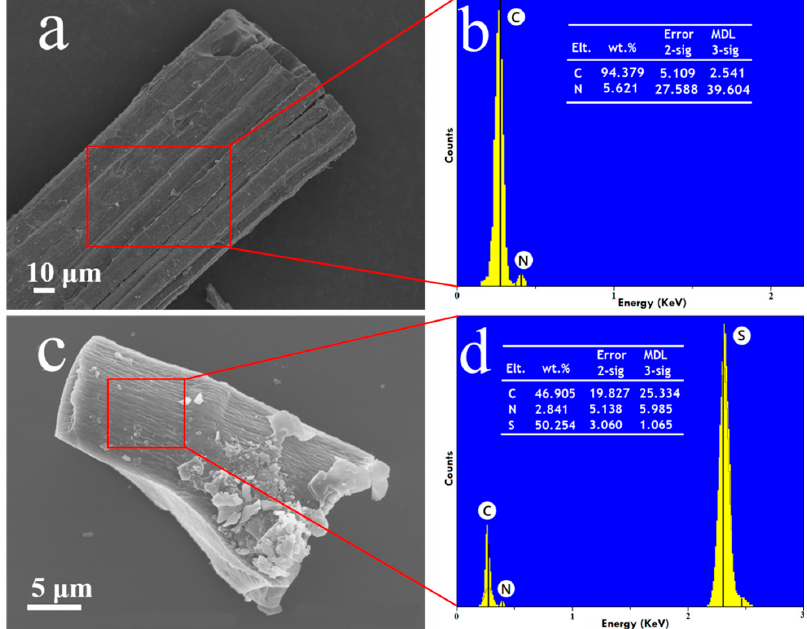
Figure 1. ( a , b ) SEM images of the RC sample, ( c ) TEM image of the RC sample, ( d ) EDS mapping of the RC, ( e ) SEM image of the RCS, ( f ) TEM image of the RCS, ( g ) SAED pattern of the RCS sample and ( h ) EDS mapping of the RCS.